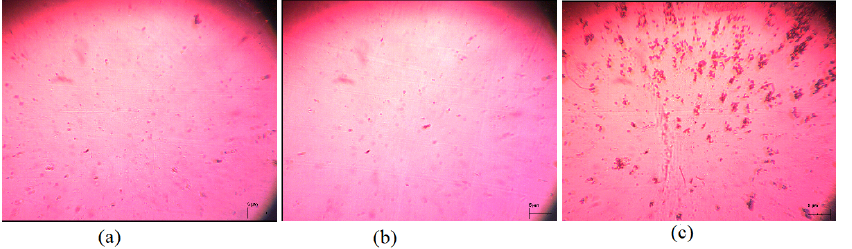
Figure 3. Polarized microscopy images recorded for planar aligned cells: ( a ) for 7CB sample, ( b ) for 7CB + 0.36% MWCNT and ( c ) for 7CB + 1.30% MWCNT